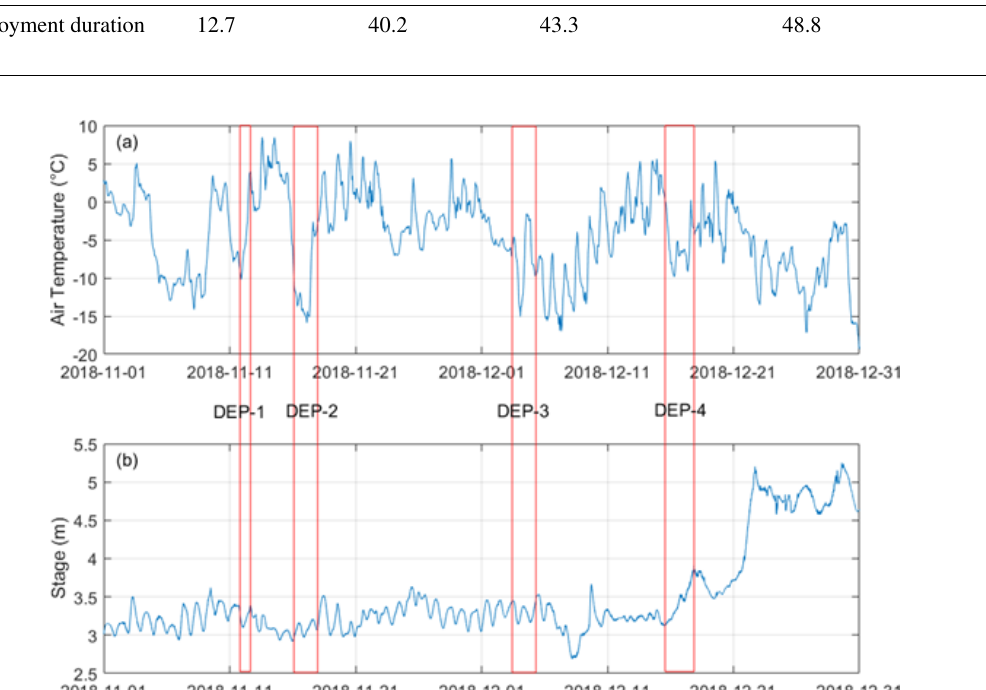
Figure 4. Time series of (a) air temperature and (b) river stage during the 2018 freeze-up season. Field deployments are delineated with red